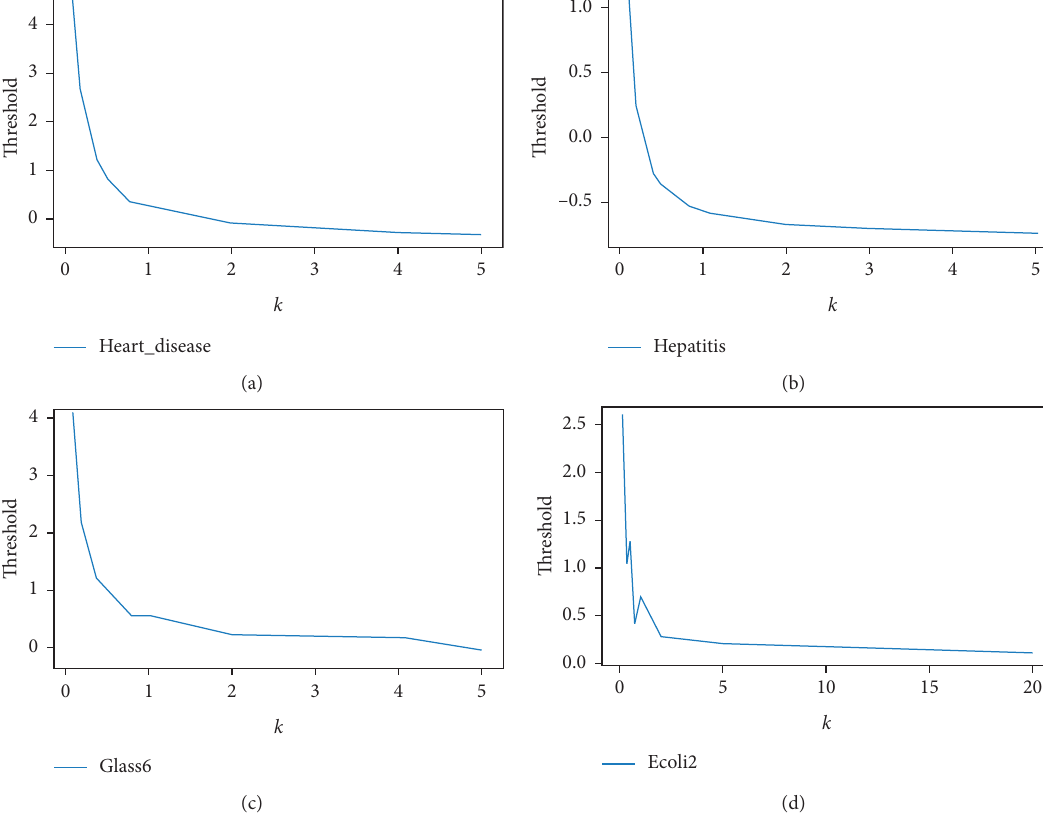
Figure 4: Influence of k on the ROC